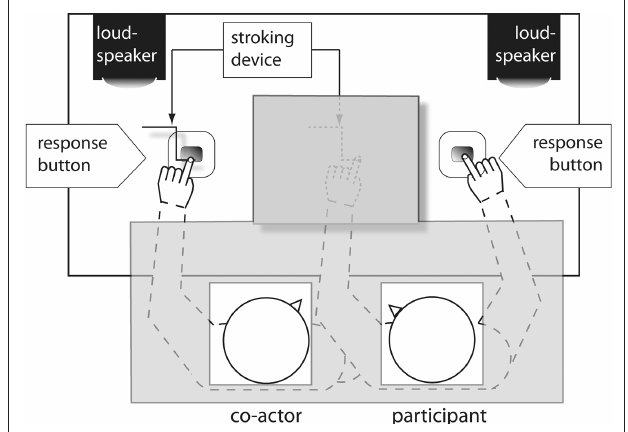
Figure 1 | experimental setting in experiment 1. Gray shaded areas indicate areas obscured